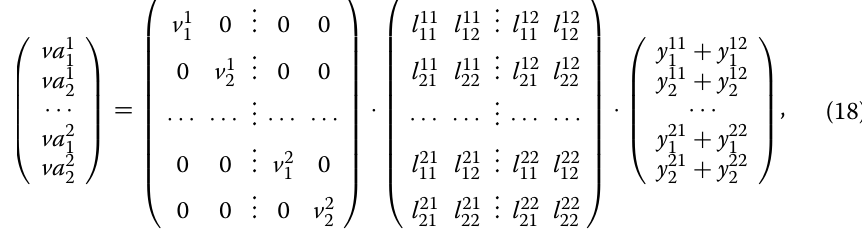
output table. A case of study in South America. Struct Change Econ Dyn 52:130–140. https ://doi.org/10.1016/j.strue co.2019.08.003 Boero R, Edwards BK, Rivera MK (2018) Regional input–output tables and trade flows: an integrated and interregional non‑survey approach. Reg Stud 52(2):225–238. https ://doi.org/10.1080/00343 404.2017.12860 09 Chen G, Wiedmann T, Wang Y, Hadjikakou M (2016) Transnational city carbon footprint networks—Exploring carbon links between Australian and Chinese cities. Appl Energy 184:1082–1092. https ://doi.org/10.1016/j.apene rgy.2016.08.053 Dane (2009) Methodology. International Standard Industrial Classification of All Economic Activities. vol 47 Dane (2019) Microdatos de Comercio Internacional. https ://sitio s.dane.gov.co/anda‑index / Gilles E (2018) Cadenas globales de valor, empleo y servicios: evidencia para algunos países latinoamericanos. Tec Empre‑ sarial 12:7–18 Hasegawa R, Kagawa S, Tsukui M (2015) Carbon footprint analysis through constructing a multi‑region input–output table: a case study of Japan. J Econ Struct 4(1):5. https ://doi.org/10.1186/s4000 8‑015‑0015‑6 Junius T, Oosterhaven J (2003) The solution of updating or regionalizing a matrix with both positive and negative entries. Econ Syst Res 15(1):87–96. https ://doi.org/10.1080/09535 31032 00005 6954 Lenzen M, Moran D, Kanemoto K, Geschke A (2013) Building Eora: a global multi‑region input–output database at high country and sector resolution. Econ Syst Res 25(1):20–49. https ://doi.org/10.1080/09535 314.2013.76993